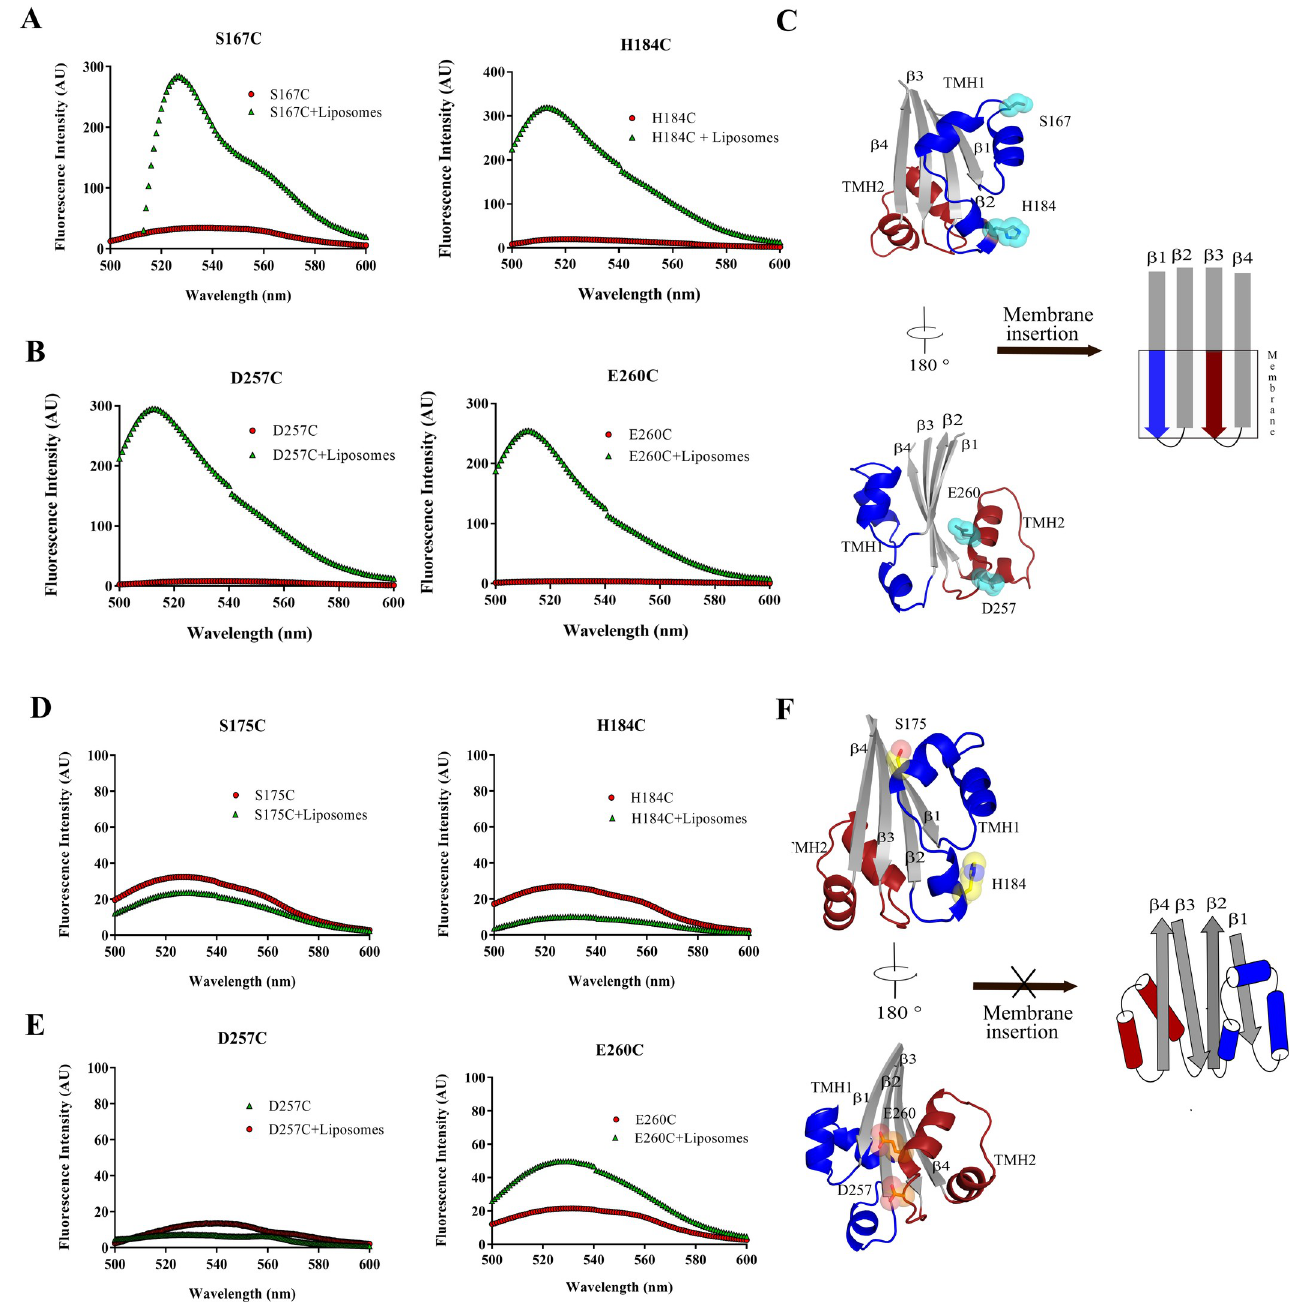
Fig 3. Ply-NH is unable to form transmembrane β -hairpins (TMH1 and TMH2) Fluorescence intensities of all the labelled proteins with and without liposomes are depicted by green triangles and red circles, respectively. The fluorescence emission scans of Ply-H labelled variants ( A ) S167C, H184C (TMH1) and ( B ) D257C, E260C (TMH2) and Ply-NH labelled variants ( D ) S175C, H184C (TMH1) and ( E ) D257C, E260C (TMH2) are shown. ( C,F ) Schematic representing formation of TMH in Ply-H (C) and its inability in Ply-NH (F). derivative of serotype 2 strain D39, R6:Ply-H, that is more readily internalized than its parent strain, and its allele 5 ply mutant R6:Ply-NH (S6A, S6B and S7A Figs). Our findings revealed a significantly improved internalization capability of R6:Ply-NH into lung epithelial cells